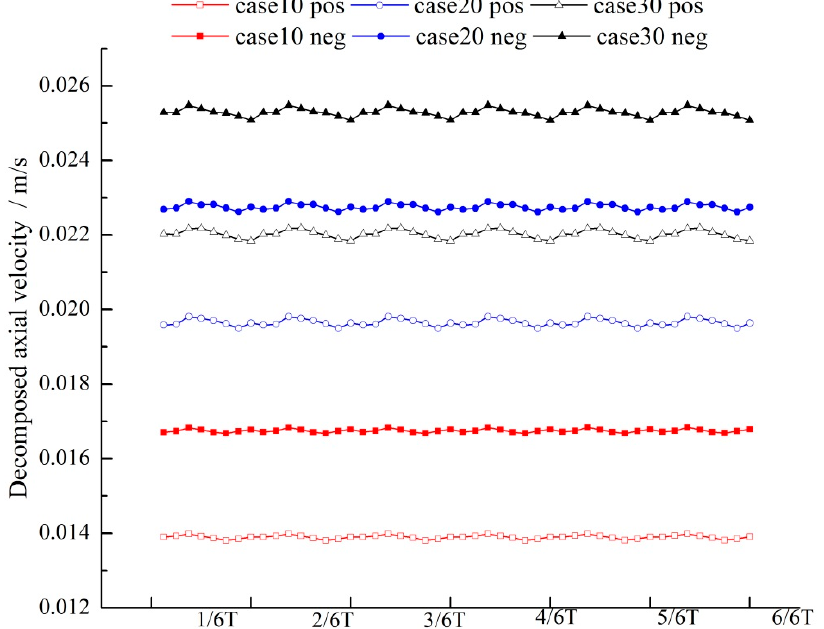
Figure 10. Evolution of the decomposed axial velocities in one revolution for different cases.